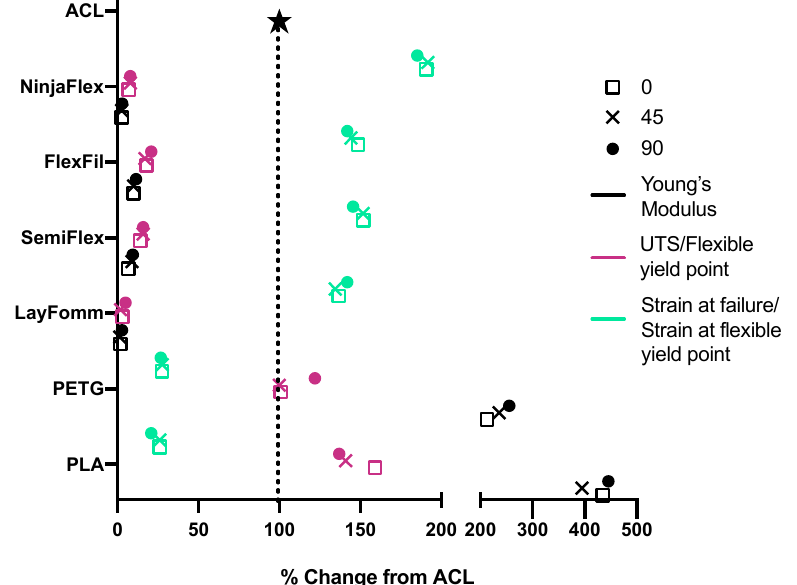
Figure 6. Percentage change of values compared to published native ACL mechanical properties. Raster angles are represented as 0°—square, 45°—cross, and 90°—circle. Young’s (stiff) or apparent (flexible) modulus values are shown in black, UTS (stiff) or flexible yield point (flexible) are pink and strain at either failure (stiff) or flexible yield point (flexible) are green. Mean values are plotted. Table 5. Mechanical properties of all specimens and ACL literature values.